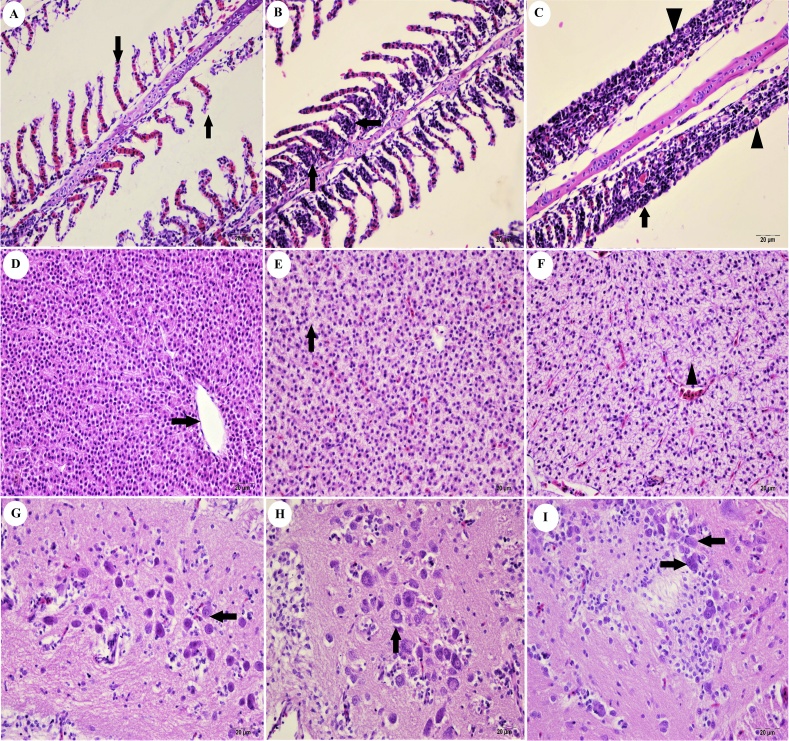
Histopathological changes of imidacloprid toxication (96 h). A) Normal histology of the gill structure (arrows). Control group. H&E. 20 μm. B) Hyperplasia of gill epithelium. Low dose toxic group, gill tissue. H&E. 20 μm. C) Hyperplasia of gill epithelium (arrow) and mucous cell hyperplasia (arrow head). High dose toxic group, gill tissue. H&E. 20 μm. D) Normal histology of liver, vena centralis (arrow). Control group. H&E. 20 μm. E). Hydropic and vacuolar degeneration in hepatocytes (arrow). Low dose toxic group, liver tissue. H&E. 20 μm. F). Diffus hydropic degeneration and focal necrosis (arrow head) in hepatocytes. High dose toxic group, liver tissue. H&E. 20 μm. G) Normal histology of neurons (arrows) in optic lobe. Control group. H&E. 20 μm. H). Normal histology of neurons (arrows) in optic lobe. Low dose toxic group. H&E. 20 μm. I), Degenerated neurons (arrows) in optic lobe. High dose toxic group H&E. 20 μm.